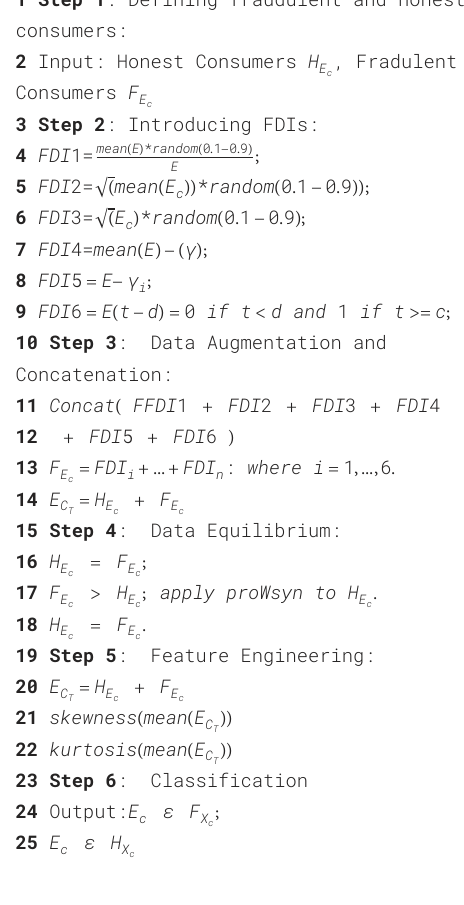
for honest consumers and 1 for fraudulent